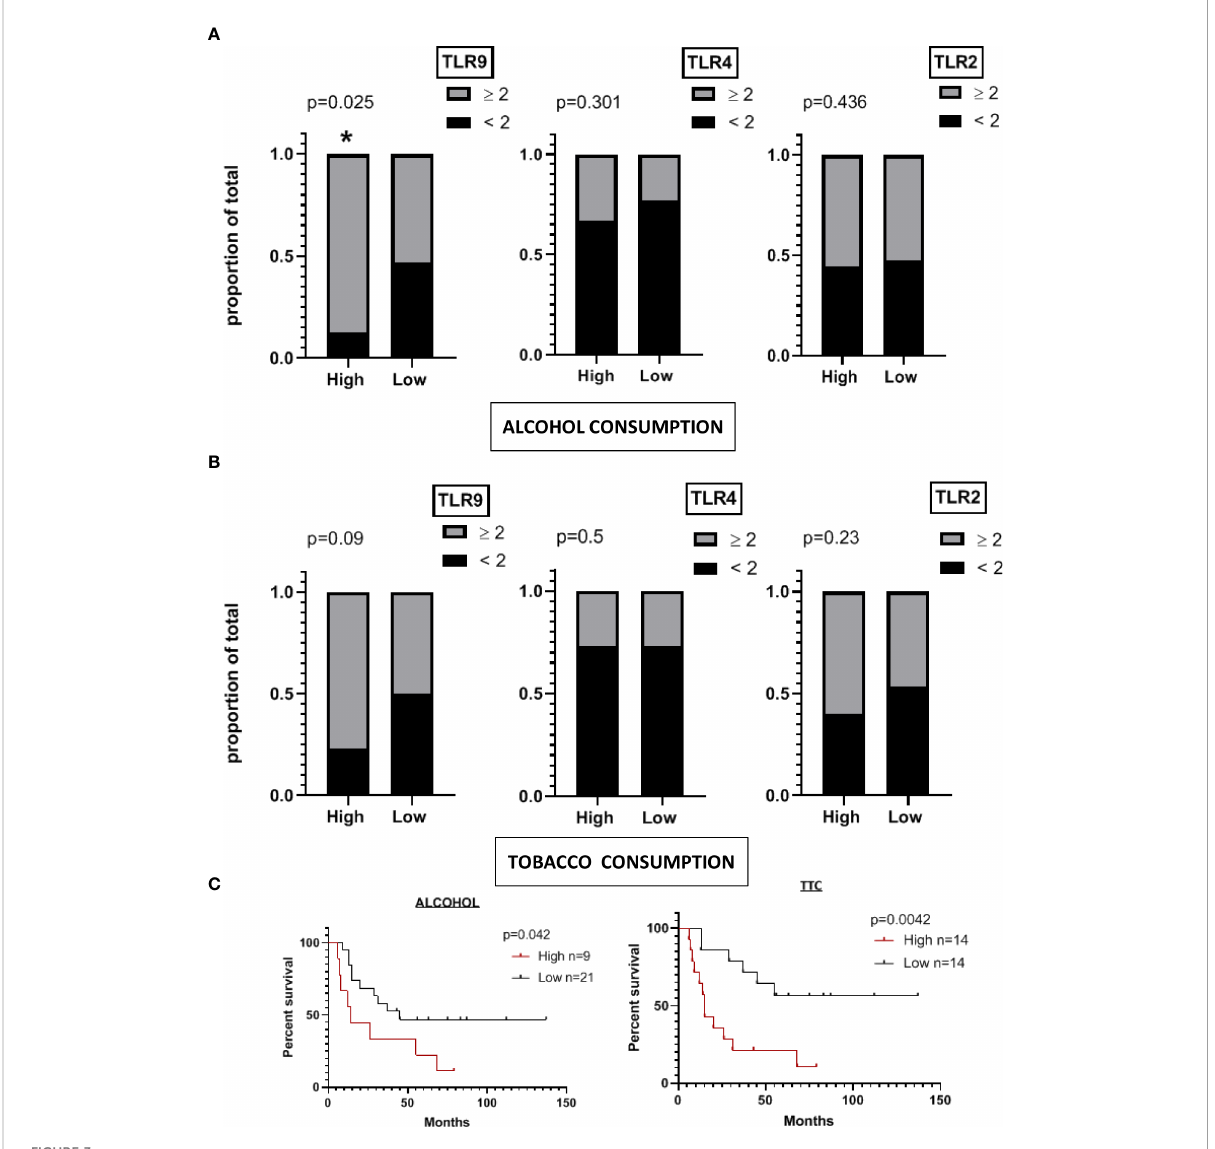
FIGURE 3 A signi fi cant proportion of OSCC tumors from heavy alcohol consumers express higher levels of TLR9. (A) Frequency of samples expressing scores ≥ 2 or < 2 of TLR9, TLR4 and TLR2 among patients categorized as heavy (n=9; high) or low alcohol consumers (n=21) (alcohol consumption > or <60 g/day). (B) Patients were categorized as high or low tobacco consumers. More than 200.000 cigarettes during his lifetime was considered to be a high consumer. A difference of proportions Z-test was performed to calculate the statistical signi fi cance. (C) Kaplan-Meier plots of overall survival of patients categorized as high or low alcohol or tobacco (TTC) consumers. * p < 0.05 was considered statistically signi fi